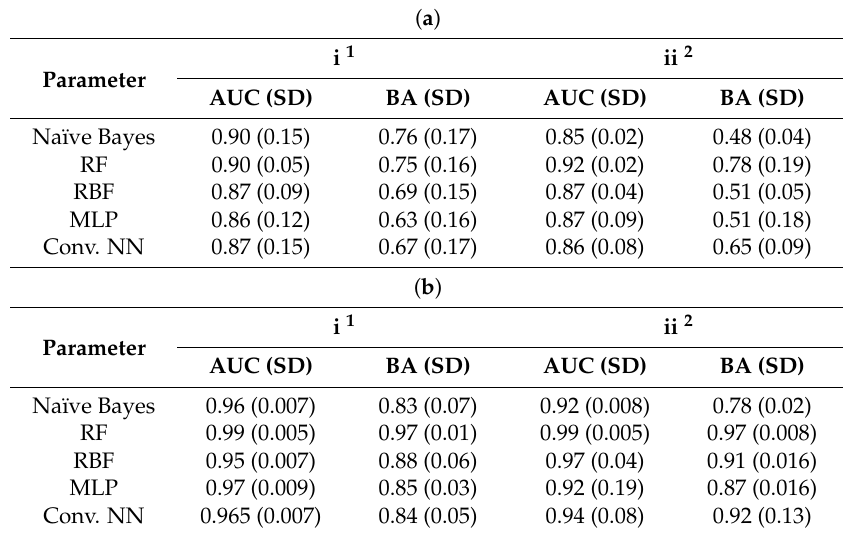
Table 1. Average values of performances obtained for the ( a ) initial datasets before balancing and ( b ) balanced modeling sets using multiple machine learning